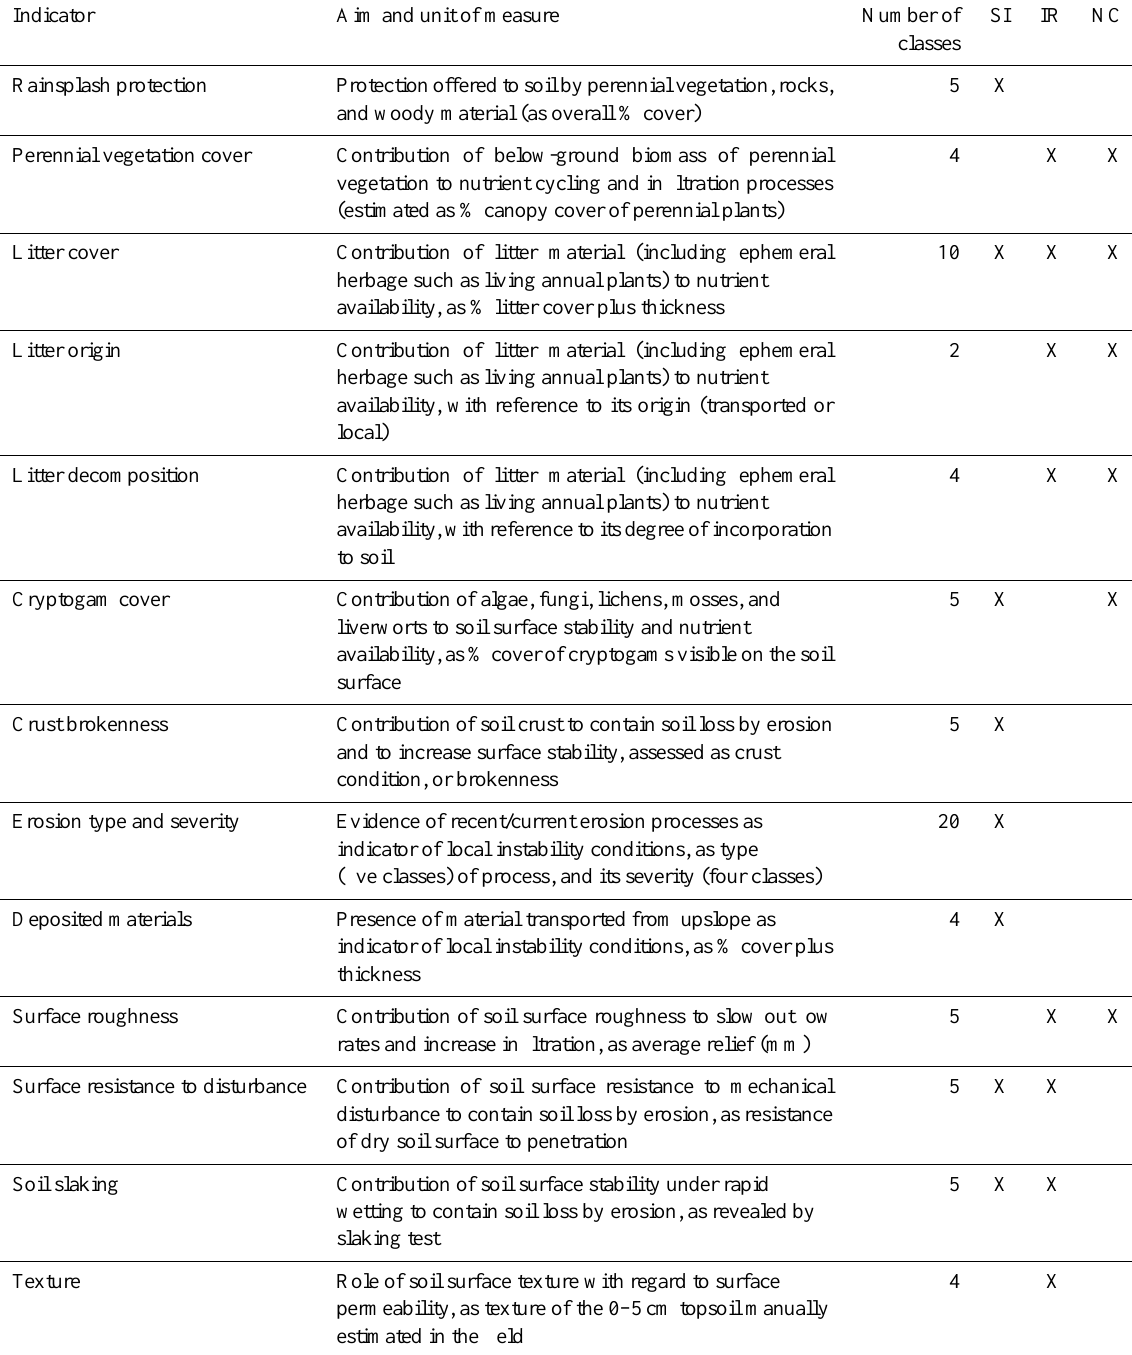
Table 6. The LFA method (Tongway and Hindley, 2004) uses 13 soil surface field indicators, determined in query zones, and is used to calculate three composite indices (stability, SI; nutrient cycling, NC; infiltration/runoff,